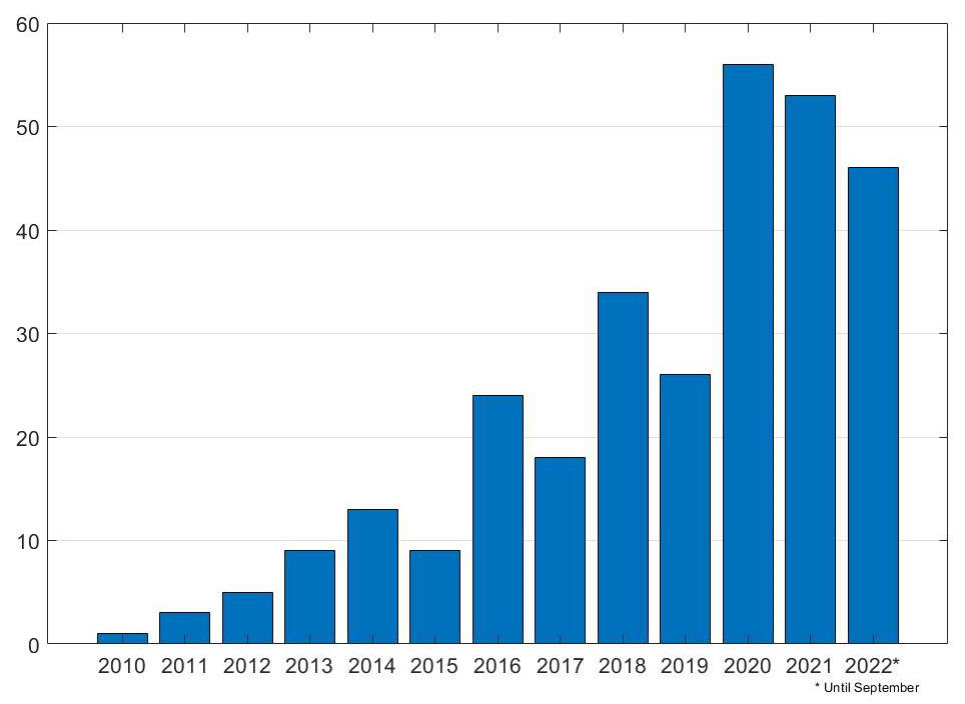
Figure 3. Evolution of the number of computer vision articles applied to fish monitoring and management. Numbers were compiled using the search results described in Section